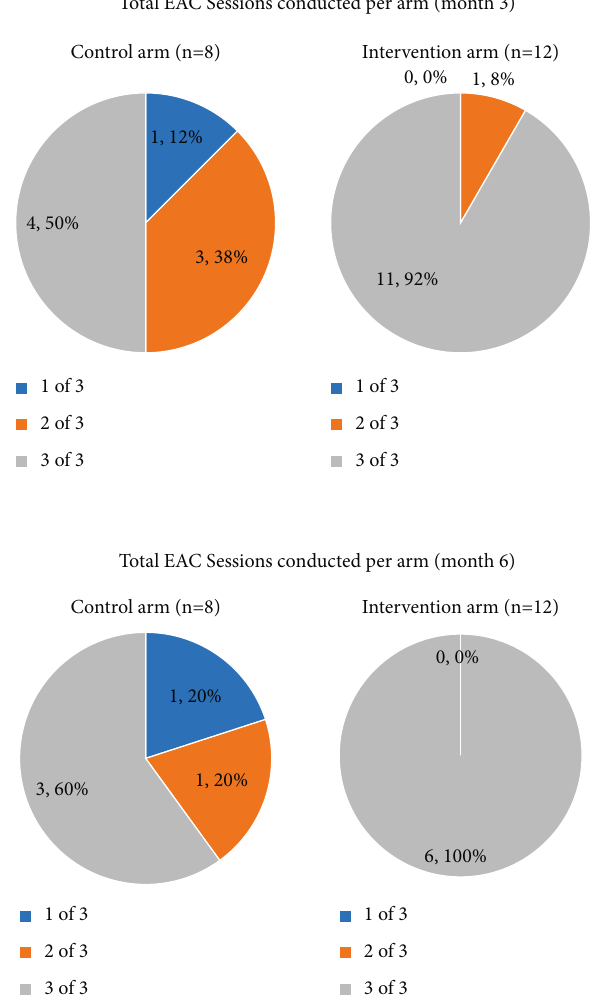
Figure 2: Number of EAC sessions conducted for participants with VL ≥ 200 copies/ml according to arm.